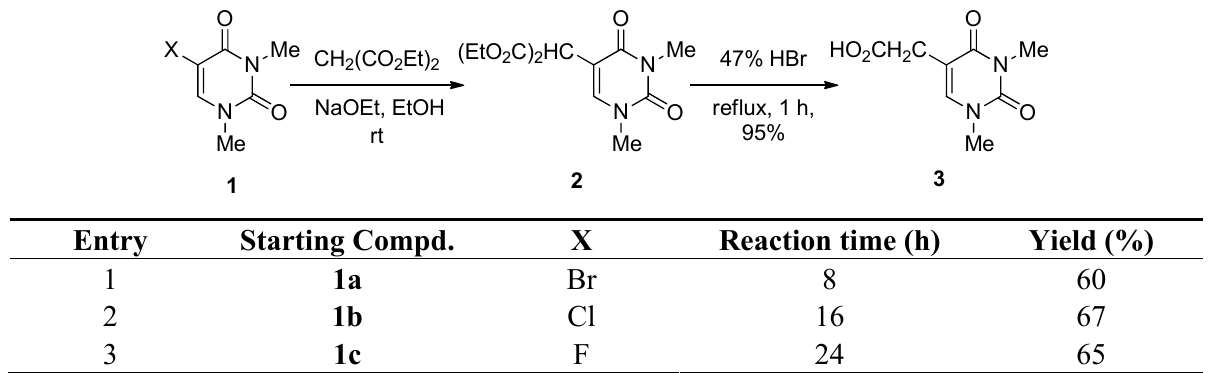
Table 2. Formation of 5-bis(ethoxycarbonyl)methyl-1,3-dimethyluracil ( 2